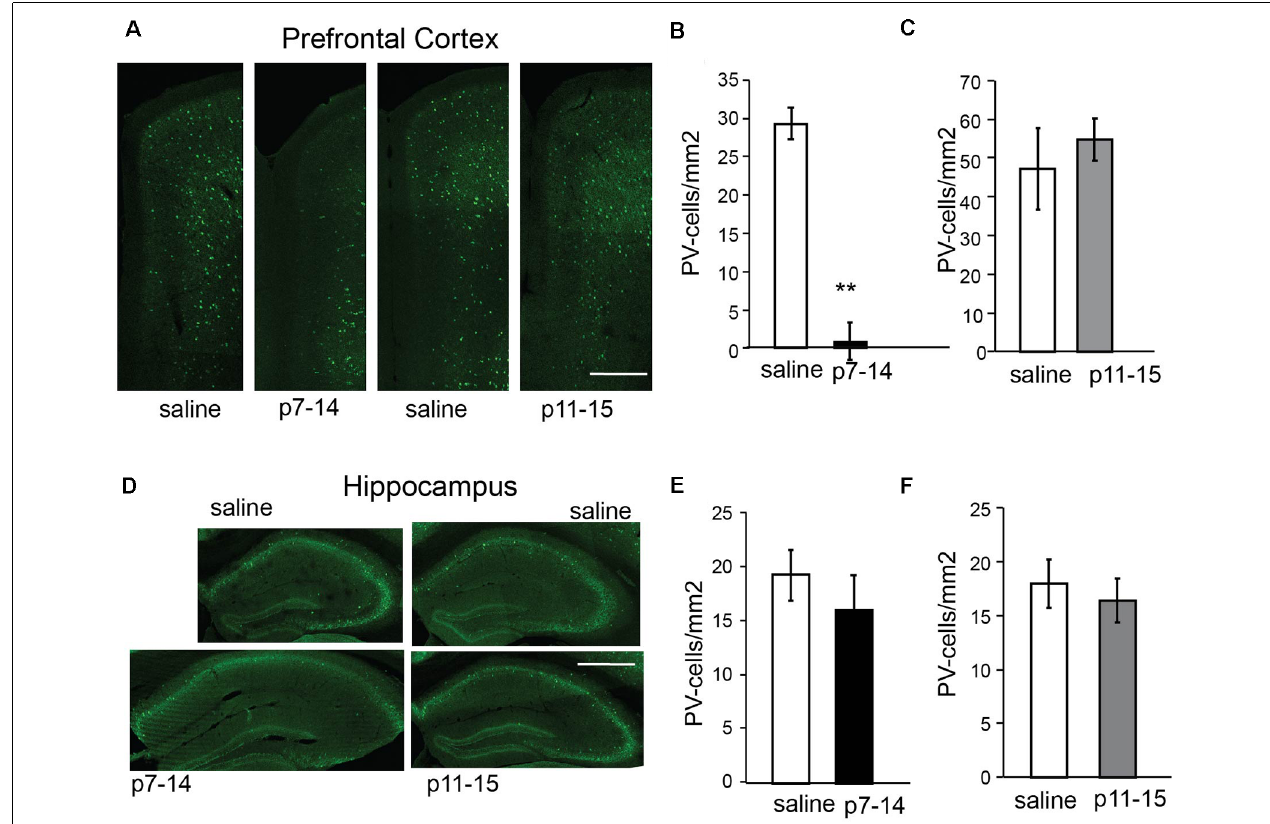
FIGURE 7 | Number of PV-expressing cells in the PFC and HPC of nMK-801 (p7–14; n = 3) and nMK-801 (p11–15; n = 3) compared to saline-treated controls ( n = 6 total, pooled from both p7–14 and p11–15 groups). (A–C) Representative images (scale bar: 0.5 mm) (A) and graphs showing that the number of PV-expressing cells is reduced in the PFC of nMK-801 (p7–14)-treated mice are reduced compared to their saline controls ( t -test, p = 0.002) (B) , while the number of PV-expressing cells in the nMK-801 (p11–15)-treated mice is not affected compared to saline-treated controls ( t -test, p = 0.3) (C) . (D–F) Representative images (scale bar: 1 mm) (D) and graphs showing that the number of PV-expressing cells is not different in the HPC of nMK-801 (p7–14)-treated mice compared to their saline controls ( t -test, p = 0.5) (E) , or the HPC of nMK-801 (p11–15)-treated mice compared to saline-treated controls ( t -test, p = 0.2) (F) . ** p <